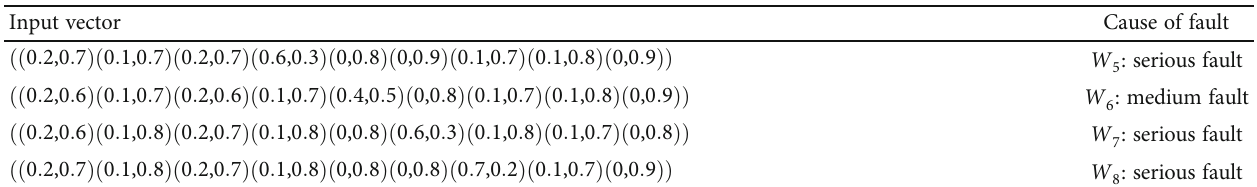
Figure 3: Fuzzy rules. Table 1: Test